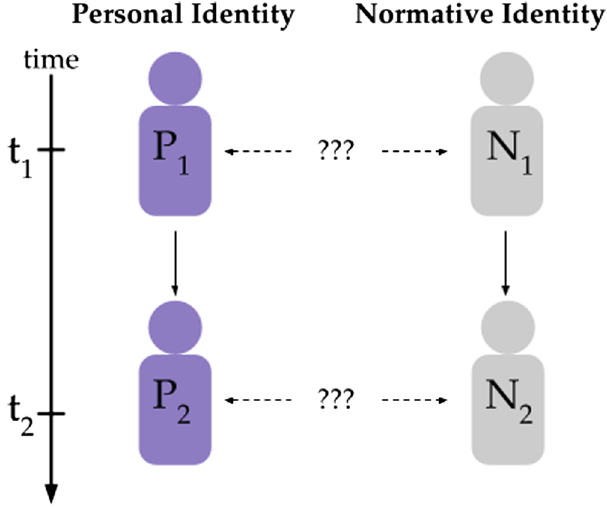
FIG. 1. Analytical framework of personal and normative identity. Time goes from top to bottom. Personal identities are purple and normative identities are gray. Both personal and normative identity can evolve over time in ways that lead to greater or less